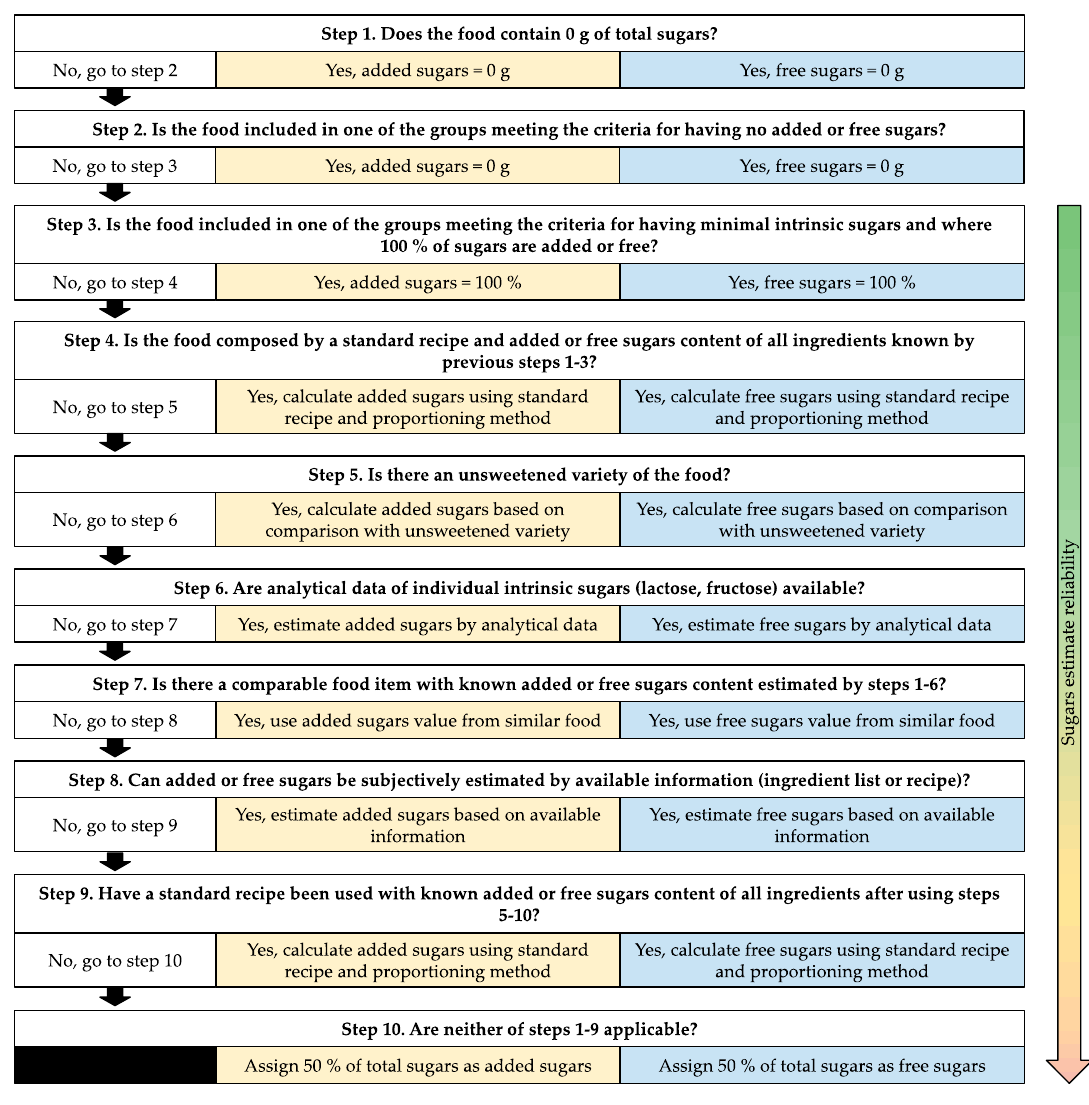
Figure 1. Ten-step decision-making procedure for estimating added and free sugars content in food items. Yellow boxes (middle column) indicate stepwise decision for added sugars, blue boxes (right column) for free sugars. The refined procedure is based on two previously described procedures by Louie et al. [10] and Kibblewhite, Nettleton et al. [11] .